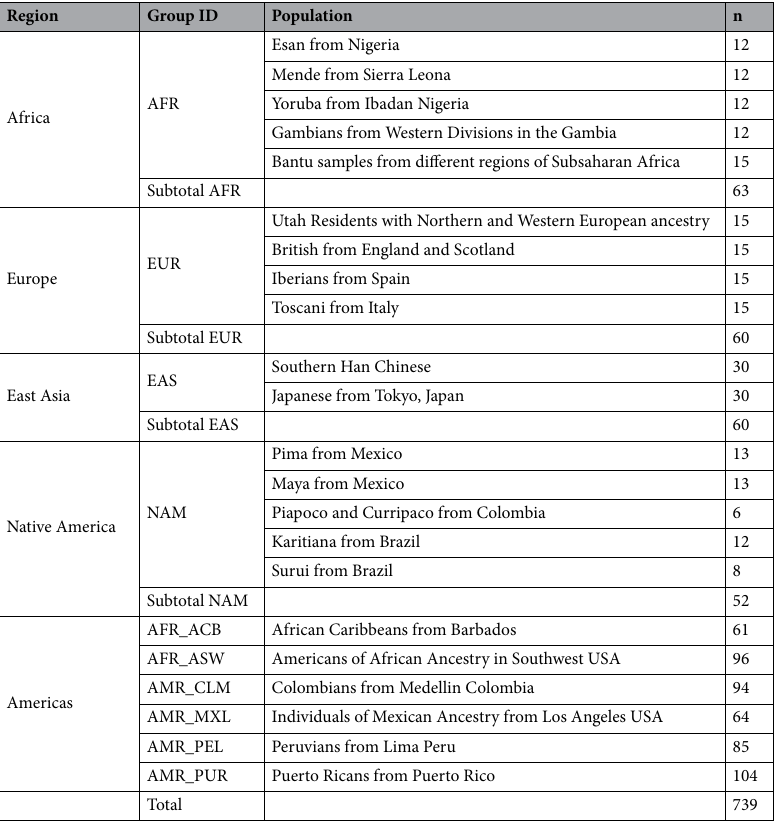
Table 1. Reference and admixed populations cohorts obtained from 1000 Genomes Project and Human Genome Diversity